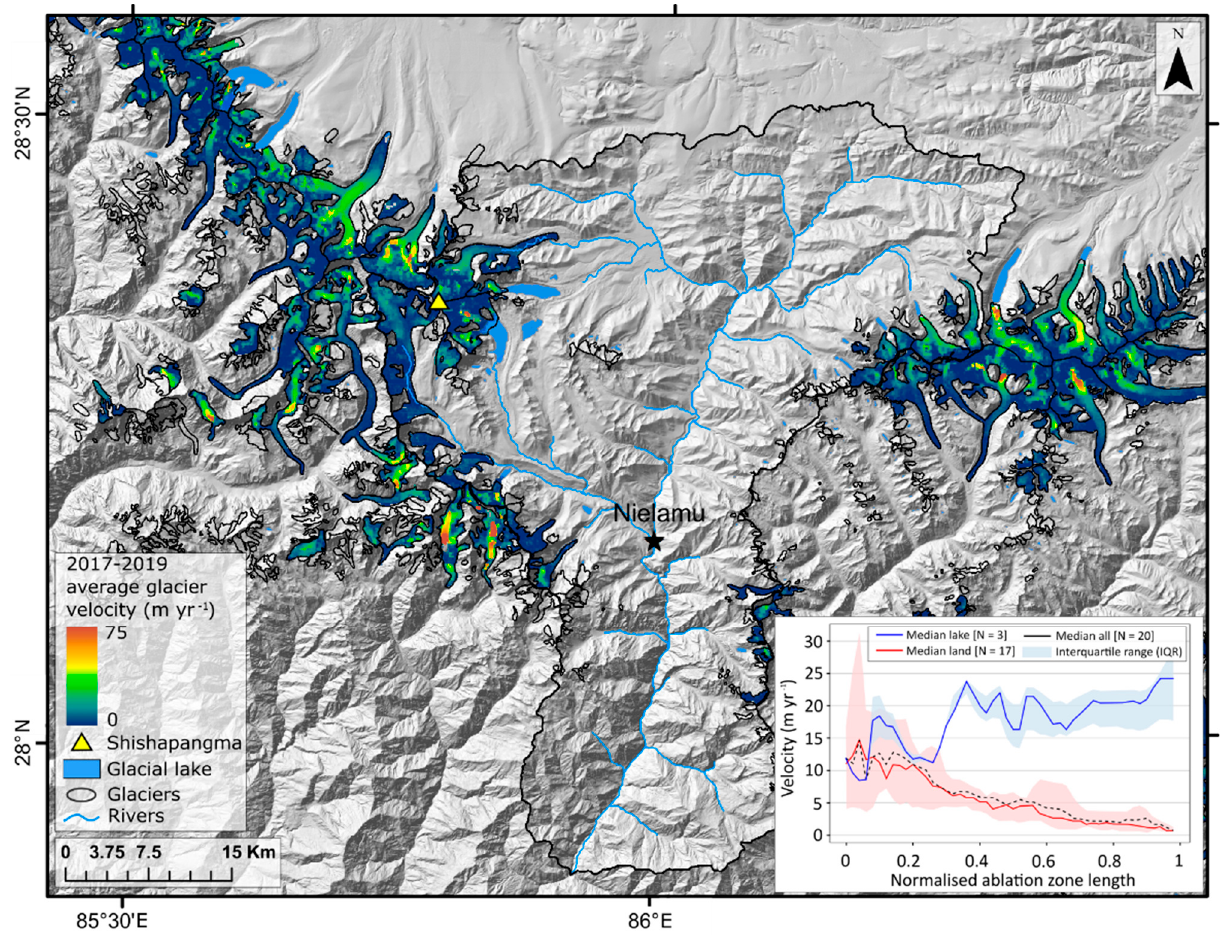
Figure 5. Surface velocity of glaciers in the Poiqu basin and surrounding area, inset: centreline velocities of the ablation areas of lake- and land-terminating glaciers in the Poiqu River basin (data source: [52]).